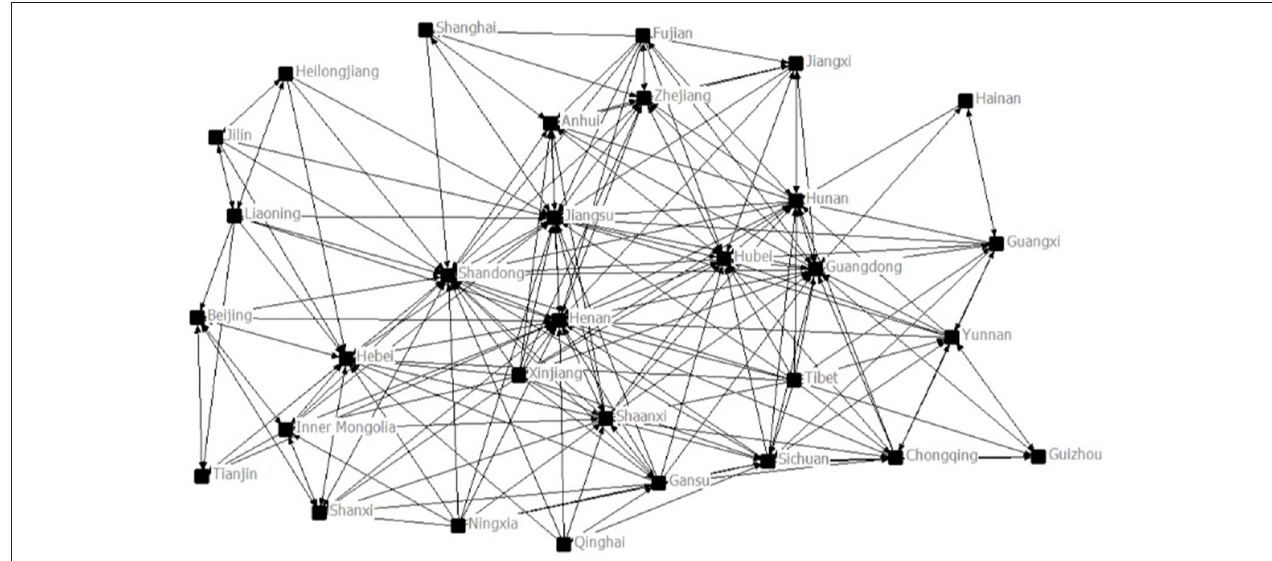
FIGURE 1 | The economic network construction of